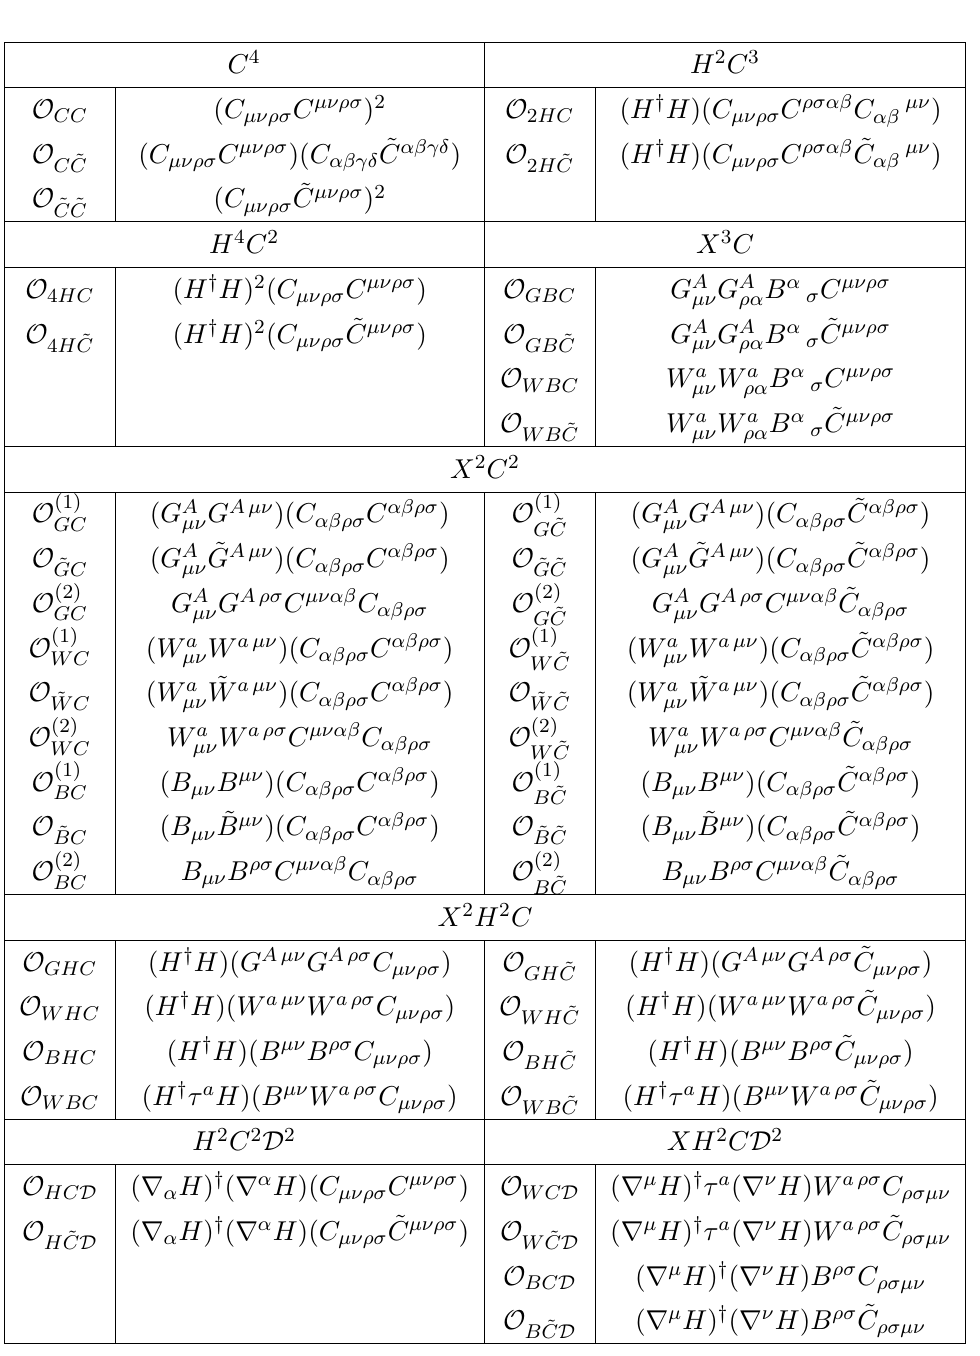
Table 3 . Bosonic dimension-8 operators of the GRSMEFT including gravitational